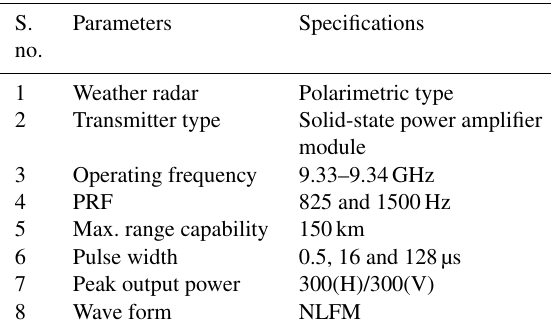
Table 1. Important specifications of DROP-X.